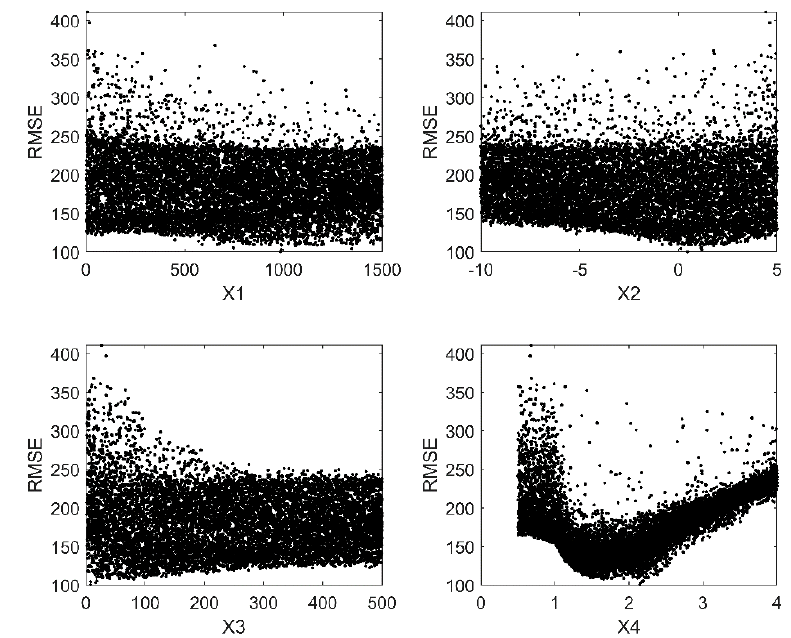
Figure 7. Scatter plot of Root Mean Square Error (RMSE) against parameter values with 10,000 runs for GR4J model.